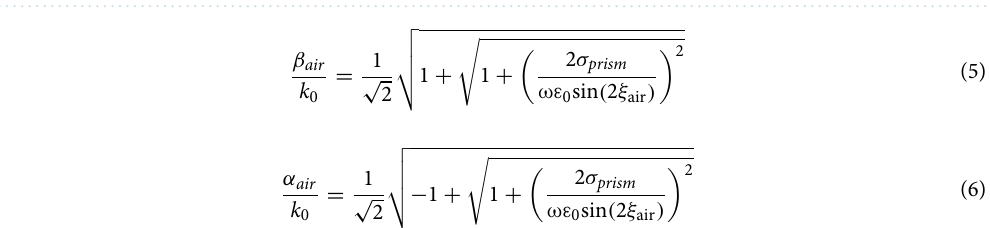
Figure 3. Design of ( a ) horn antenna, ( b ) Menzel antenna, and ( c ) horn TEM with lossy prism in front of the lossy medium on